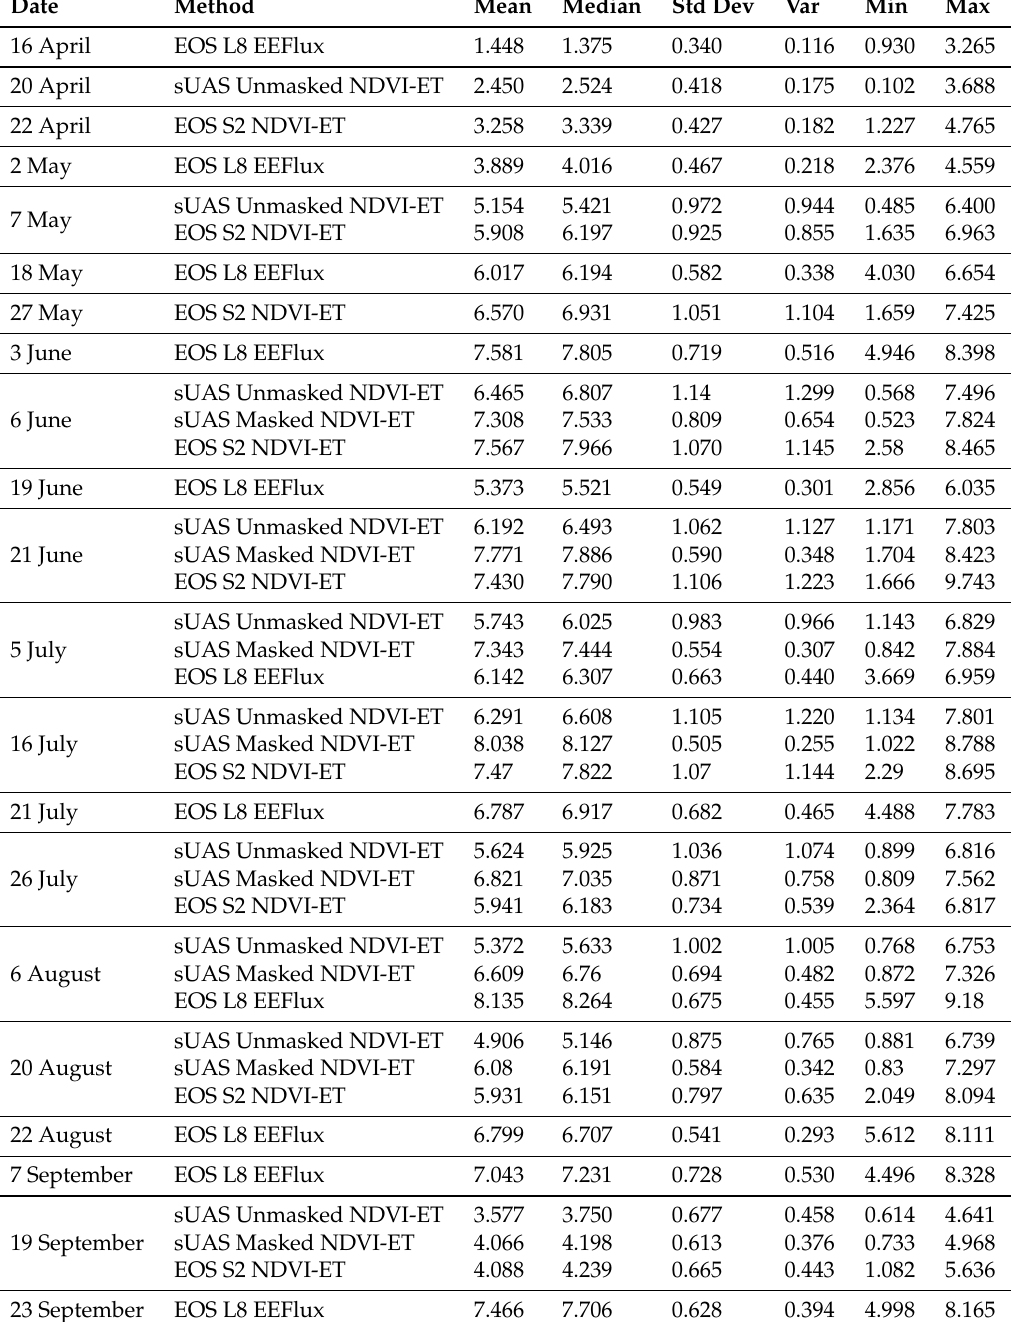
Table 2. Summary of ET (mm) estimates from sUAS and EOS observation for